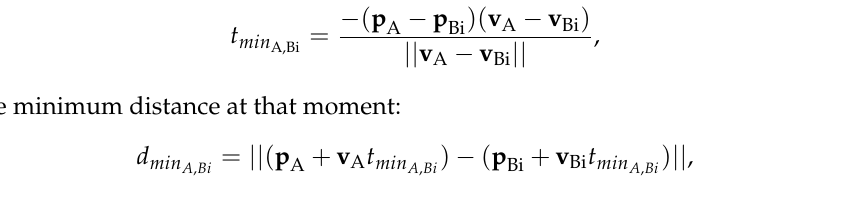
Figure 1. An example of the VO method for a robot at position p consisting of a moving obstacle B 1 at position p The gray area illustrates VO = VO 1 ∪ VO 2